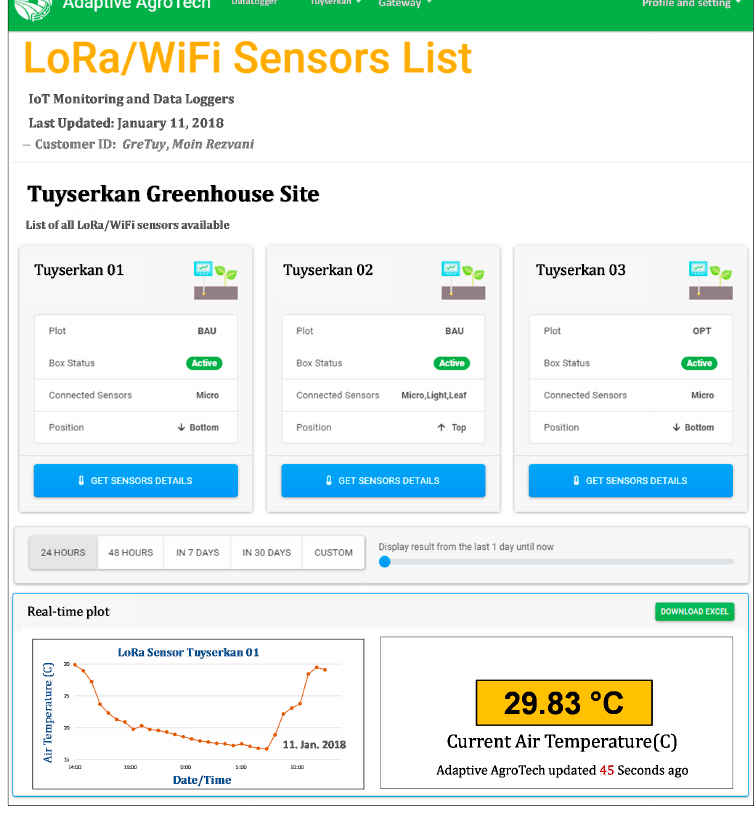
Figure 5. Screenshot of the Internet of Things (IoT) platform used for real-time data monitoring.